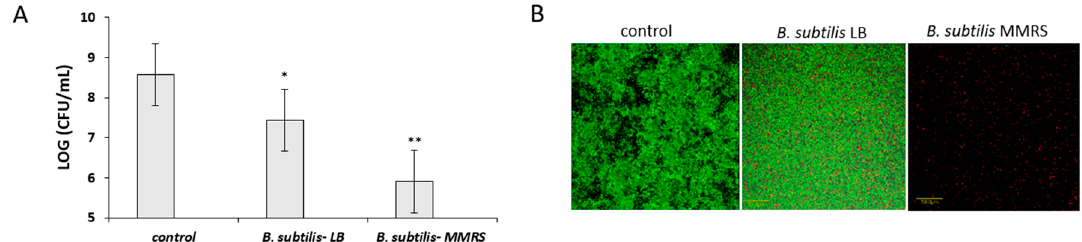
Figure 8. Type of growth medium governs the inhibitory effect on the S. aureus biofilm formation. ( A ) quantification of the S. aureus cells attached to the surface using CFU method, and ( B ) the CLSM imaging of the S. aureus biofilm formation in the presence or absence of the CSN, following growth in TSB medium with 10% supernatant at 37 °C for 24 h. * p < 0.05 for comparison of the CSN from LB to control; ** p < 0.05 for comparison of CSN from MMRS vs. LB. Error bars represent standard deviation (SD). Live cells are stained green (SYTO-9) and dead cells are stained red (propidium iodide). Scale bar = 50 µm.